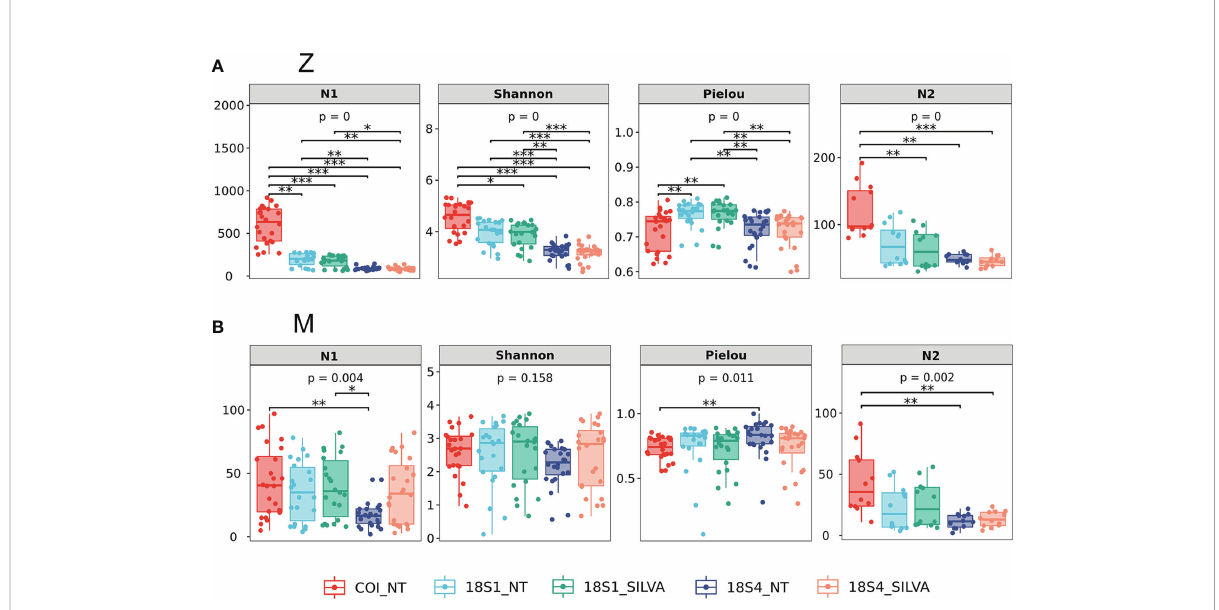
FIGURE 2 Summary of OTUs/ASVs numbers (N1), Shannon diversity, Pielou evenness and families numbers (N2) of different primers (COI, 18S1 and 18S4) and different databases (NT and SILVA). P-values for the overall test between groups were obtained by Kruskal-Wallis nonparametric test. Mark of the signi fi cance level of differences were obtained by Dunn ’ s test post-hoc comparison between each group (*, p<0.05; **, p<0.01; ***, p<0.001). (A) Z, zooplankton; (B) M,